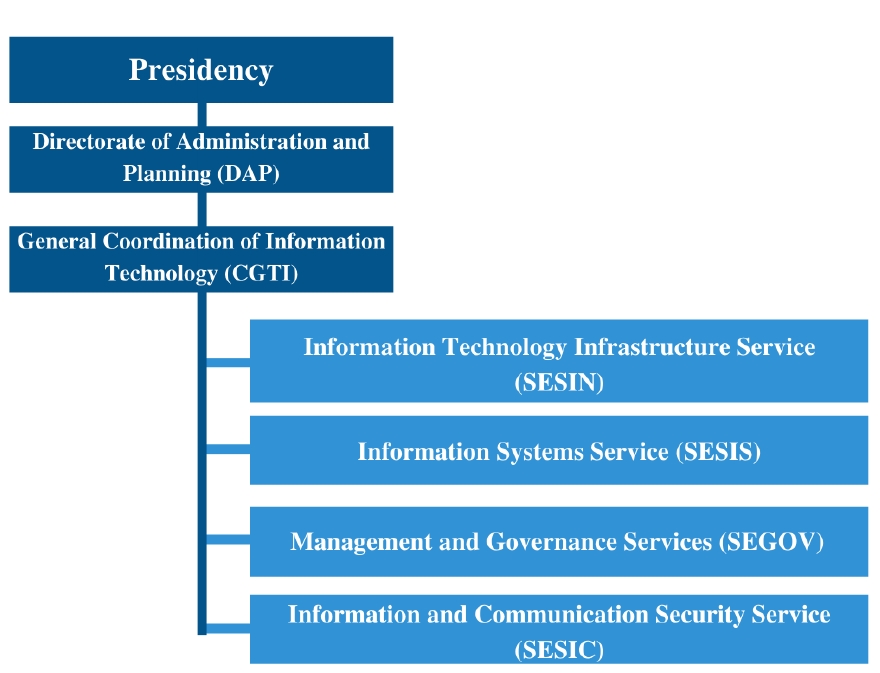
Figure 1. CADE’s General Coordination of Information Technology organizational